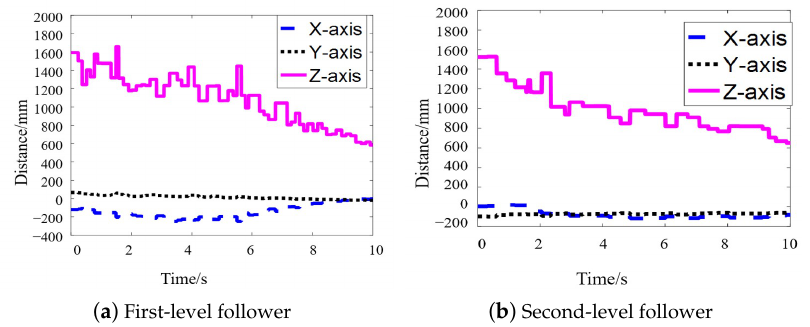
Figure 24. Distance measured by the first-level follower robot and the second-level follower robot over